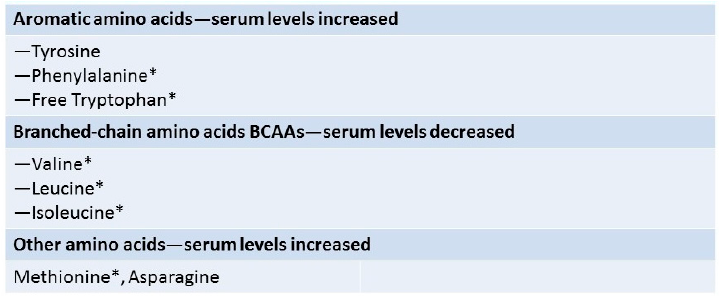
Figure 3. Amino Acids Altered in Liver Disease. The expected BCAAs/tyrosine ratio (Fisher’s ratio), should be 3.5:1; it falls to 1:1 in patients with end stage liver disease. * Essential amino